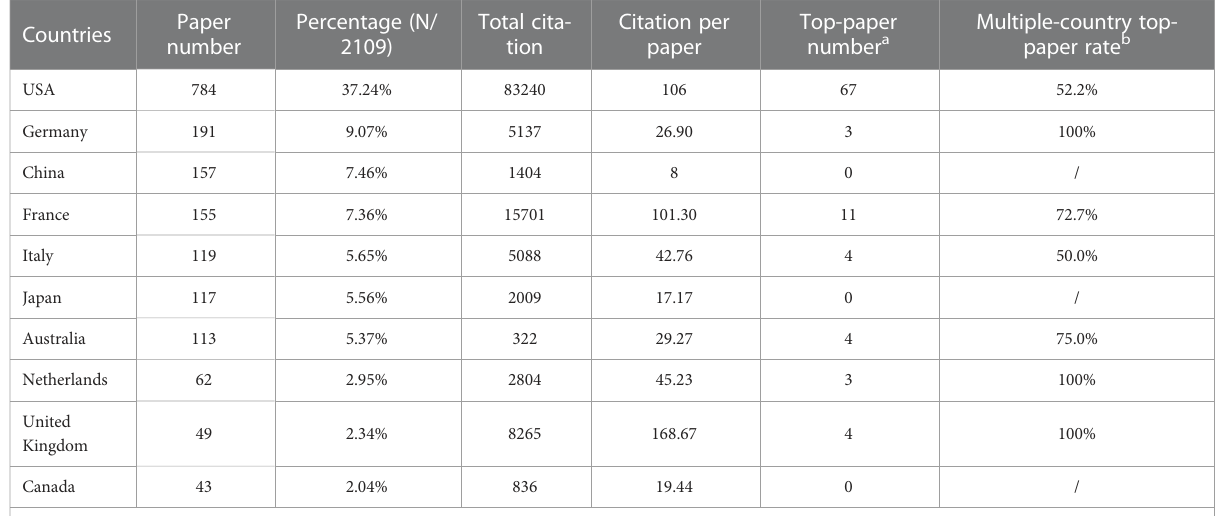
TABLE 4 The top 10 productive countries of corresponding authors of papers in melanoma immunotherapy between 2010 and 2022.